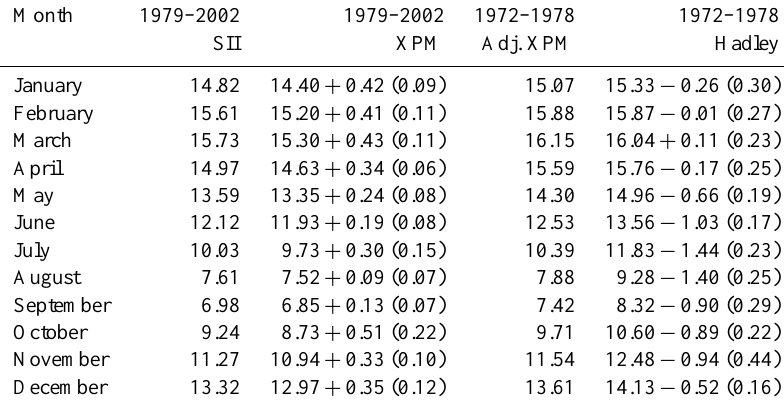
Table 2. Average extents, in 10 6 km 2 , of SII, and XMP and Hadley time series with adjustments for XPM and Hadley for overlap periods (1979–2002 XPM, 1972–1978 Hadley). Columns from left to right are: (1) month, (2) average SII monthly extent for the overlap period, 1979-2002, with XPM; (3) average XPM extent + the adjustment to match SII (St. Dev. of the average difference between XPM and SII); (4) adjusted average XPM monthly extent for overlap period, 1972–1978, with Hadley; (5) average Hadley extent + the adjustment to match the adjusted XPM (St. Dev. of the average difference between Hadley and Adj. XPM).